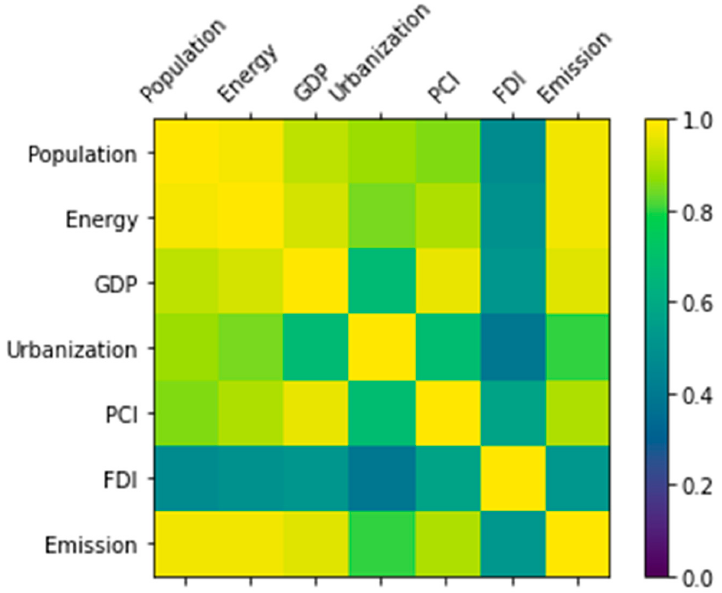
Figure 2. Correlation matrix plot of the dataset.